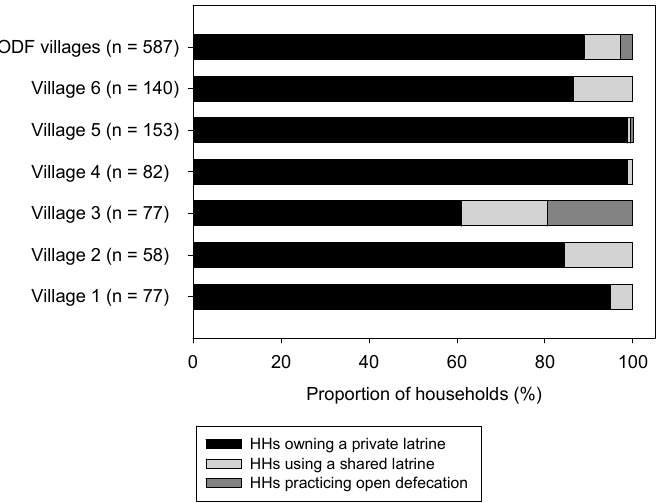
Figure 3. Proportion of households with access to a private latrine, and households without a private latrine but reporting to use a shared latrine, and reporting to practice open defecation most of times in six open defecation free (ODF) verified villages.